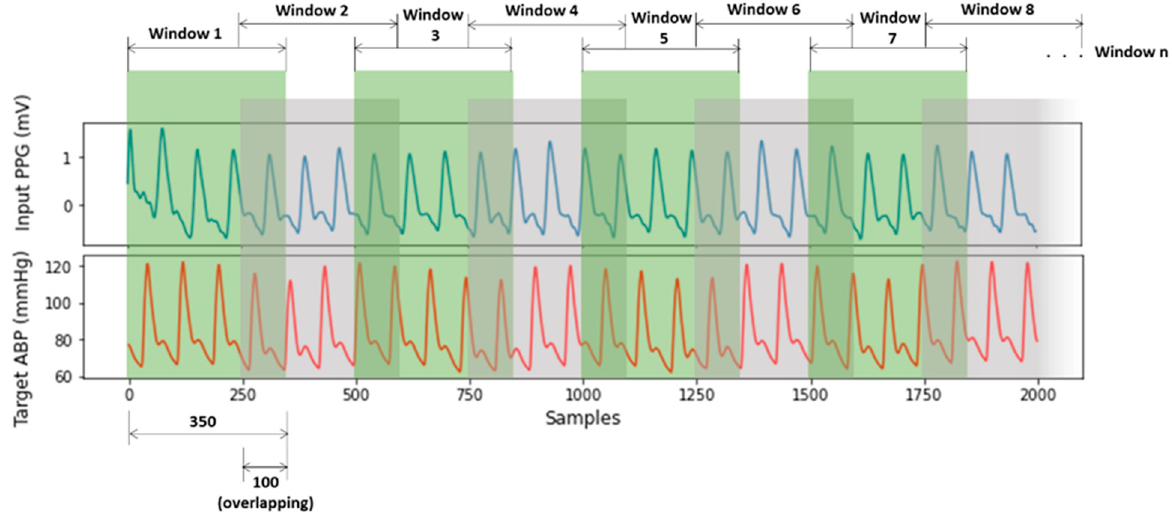
Figure 5. Windowing PPG and ABP signals.